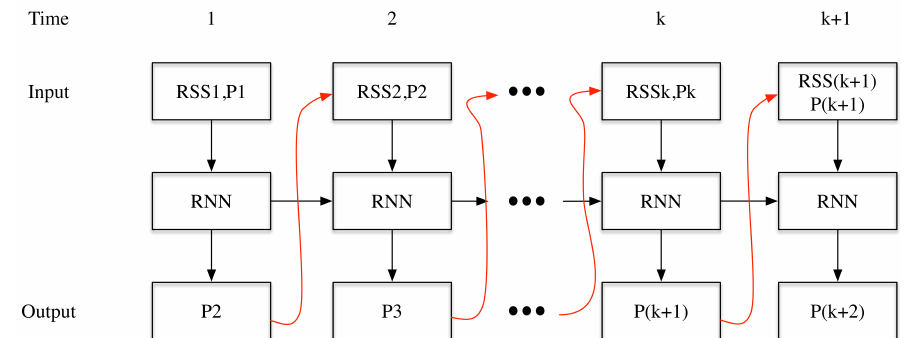
Figure 2. The Recurrent Neural Network (RNN) implementation for WiFi based fingerprinting in Reference [24], where the sequences of the fingerprints along with the positions are the input, and the sequences of the positions are the output.